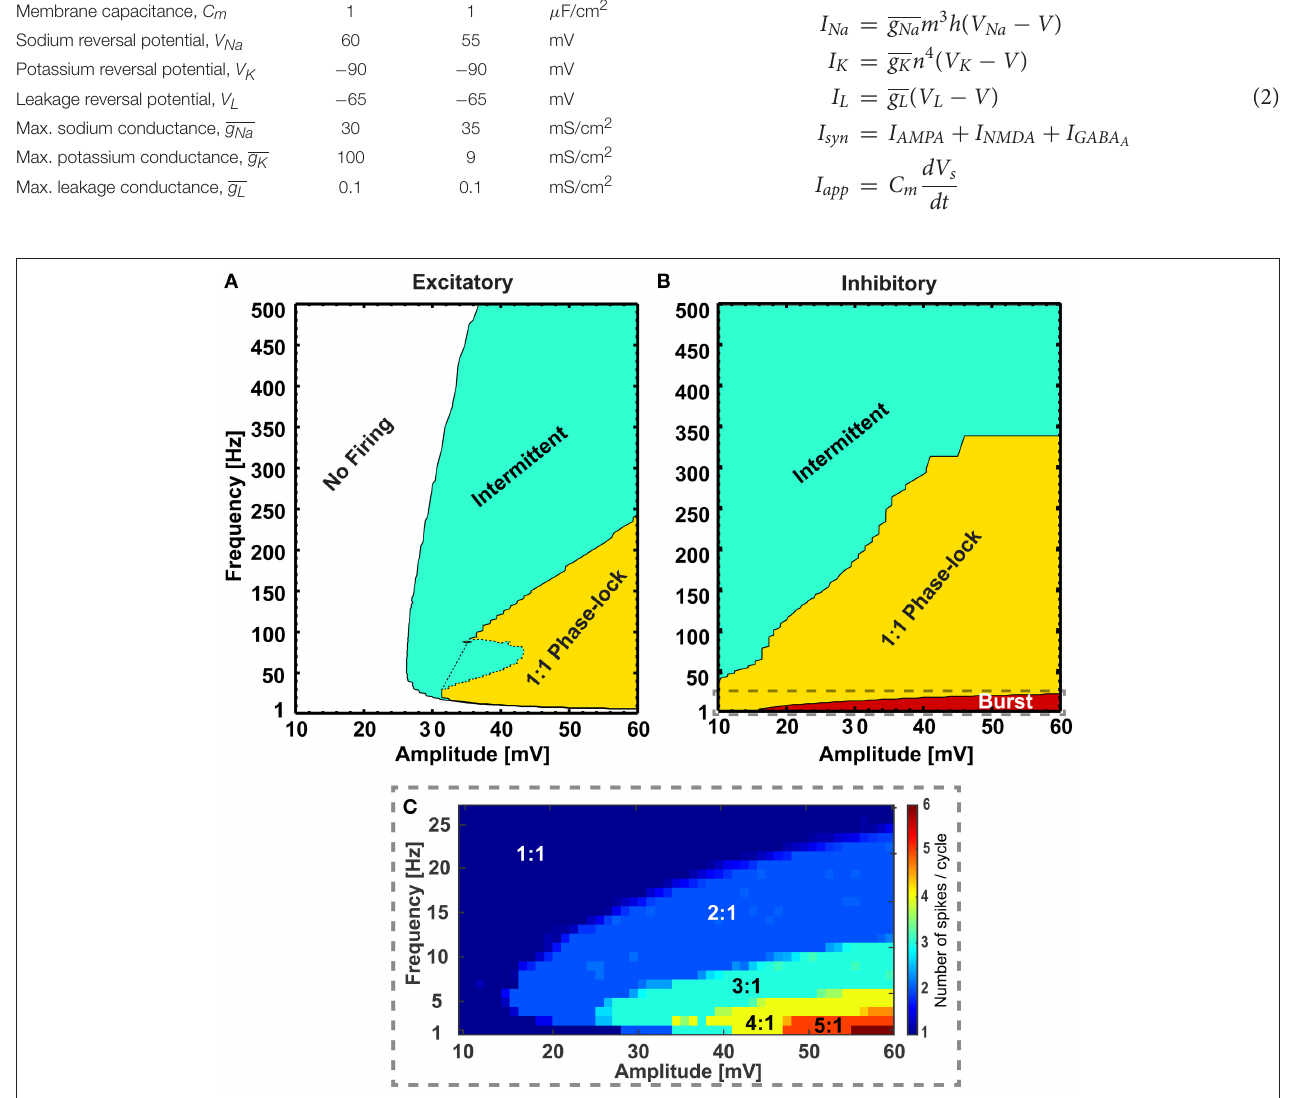
FIGURE 1 | Different firing regimes during sinusoidal stimulation. Excitatory (A) and inhibitory (B) neurons show different firing behaviors upon sinusoidal stimulation with different frequency and amplitude. The excitatory neurons do not respond to a range of amplitudes of sinusoidal stimulations ( 10 − ∼ 26 mV, “No Firing” region) and at higher amplitudes ( > 26 mV) with frequencies greater than ∼ 10 Hz they show phase lock (“ 1 : 1 Phase-lock” region) and intermittent (“Intermittent” region) firing behavior. Also, at a range of frequencies and amplitudes the excitatory neuron switches between “ 1 : 1 Phase-lock” and “Intermittent” firing [the dotted region in (A) , referred as “Knee”]. On the other hand, the inhibitory neurons show bursting behavior in low frequencies [“Burst” region, zoomed in (C) ], with gradual transition to phase-lock (“ 1 : 1 Phase-lock” region) and intermittent (“Intermittent” region) firing behavior with increasing amplitude and frequencies of the sinusoidal stimulations. In the burst region, the inhibitory neuron emits a varied number of action-potentials per cycle of stimulation (C) starting from 2 : 1 to 6 : 1 for the explored range of frequency and amplitude.